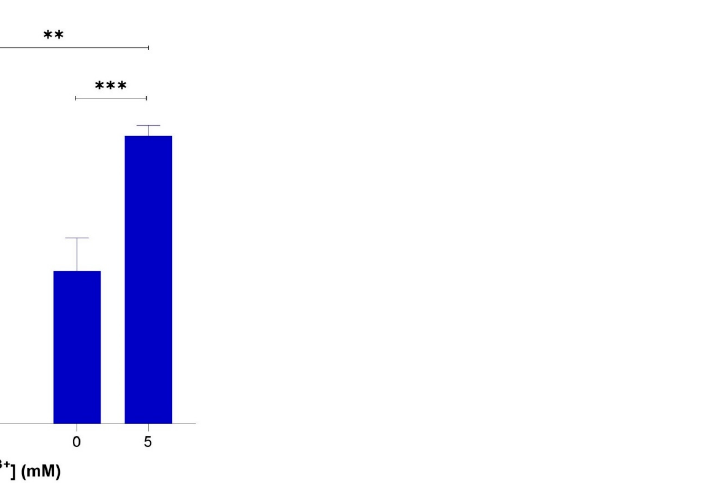
Figure 5. Al 3+ induced reactive oxygen species (ROS) generation in S. cerevisiae BY4743 [pYEX.A β ] (blue bar) and BY4743 [pYEX.BX] (green bar) using 2,7-dichlorodihydrofluorescein diacetate (H 2 DCFDA) staining. Values of dichlorofluorescein (DCF)-positive cell counts after 5 mM Al 3+ treatment are from triplicates; the mean and standard deviation are shown. Values significantly different from 0 mM Al 3+ and between the two transformant strains in a two-way ANOVA with Tukey’s post hoc analysis are indicated with asterisks: * p < 0.0312, ** p < 0.0074, *** p < 0.0005 . 2.4. Glutathione Alleviates Al 3+ - and A β 42 -Enhanced Induction of ROS To determine whether reduced glutathione could rescue ROS induced by Al 3+ and enhanced by A β 42 , equimolar (5 mM) glutathione (GSH) was included in intracellular ROS analysis. Yeast cells expressing A β 42 were treated with 5 mM GSH and 5 mM Al 3+ , and the percentage of DCF-positive cells was compared with that of those treated with 5 mM Al 3+ alone. The ROS induced by Al 3+ was almost fully reduced by GSH (Figure 6). Al 3+ -treated BY4743 [pYEX.A β ] DCF-positive cells reduced from 32.2% to 17.9% (reduction of 14.2%) and brought the levels of ROS back down to nearly the initial percentage of DCF-positive (17.1%) cells of the Al 3+ -untreated control population.